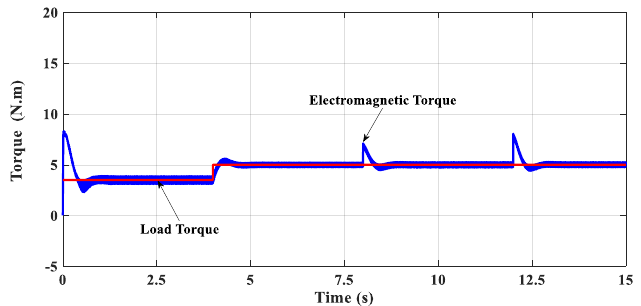
Figure 15. Speed-estimation error under parameter changes (150% uncertainty).